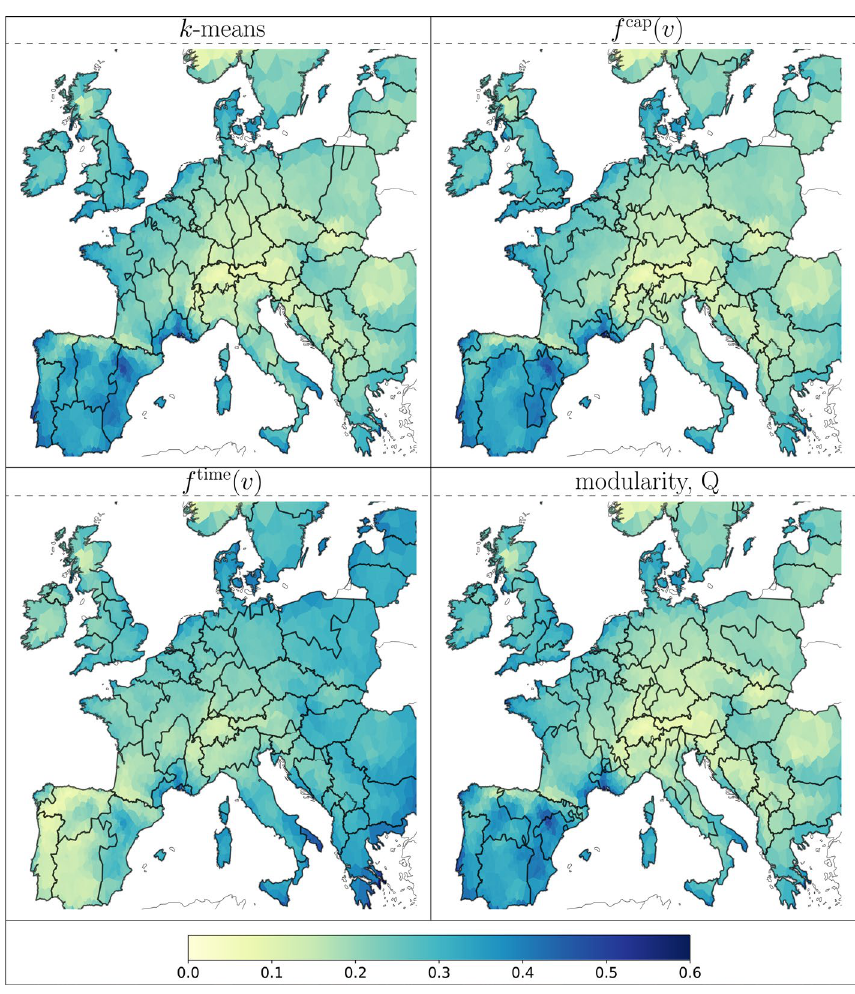
Fig. 4 Resulting regions respective clustering method at a resolution of 67 nodes. The color-map reflects the annual capacity factors for all the methods, except for f time ( v ) , where it is the average capacity factor of the time-series at 8 o’clock in the moring. Original regions/nodes are highlighted by white boundaries of respective voronoi regions